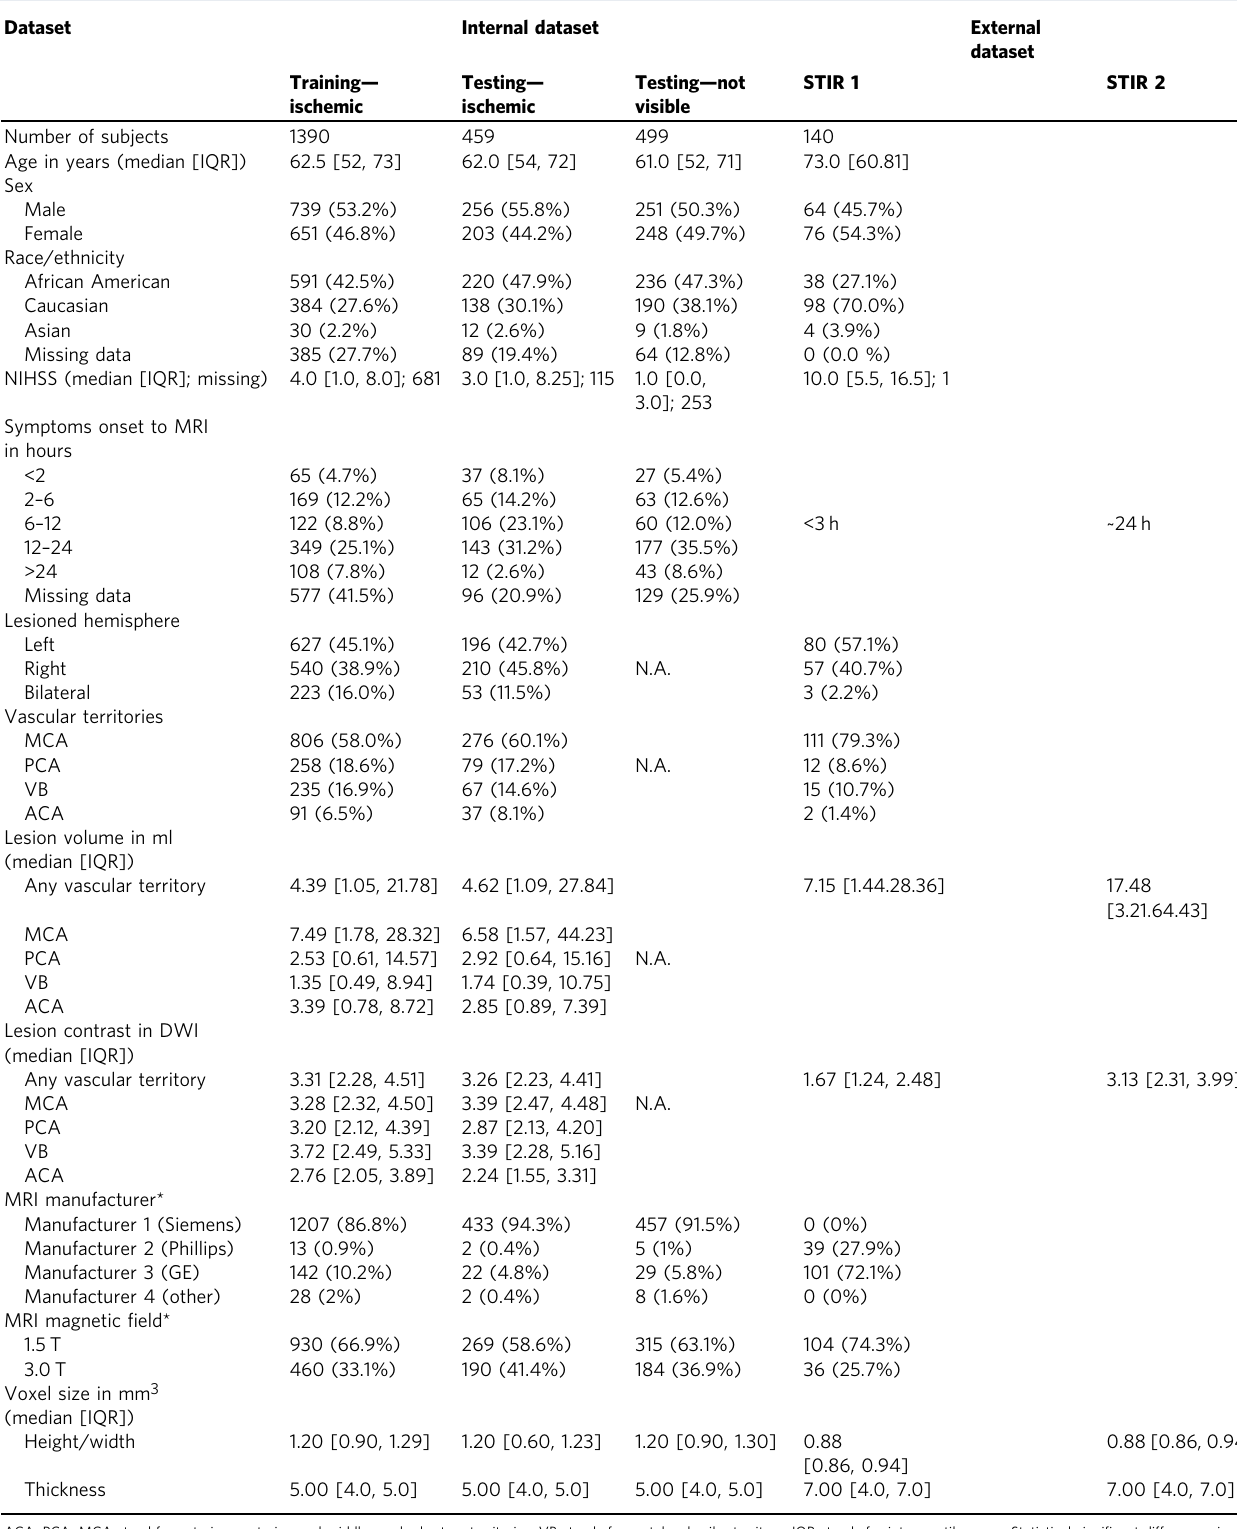
Table 1 Population, lesion, and scanner pro fi les, per